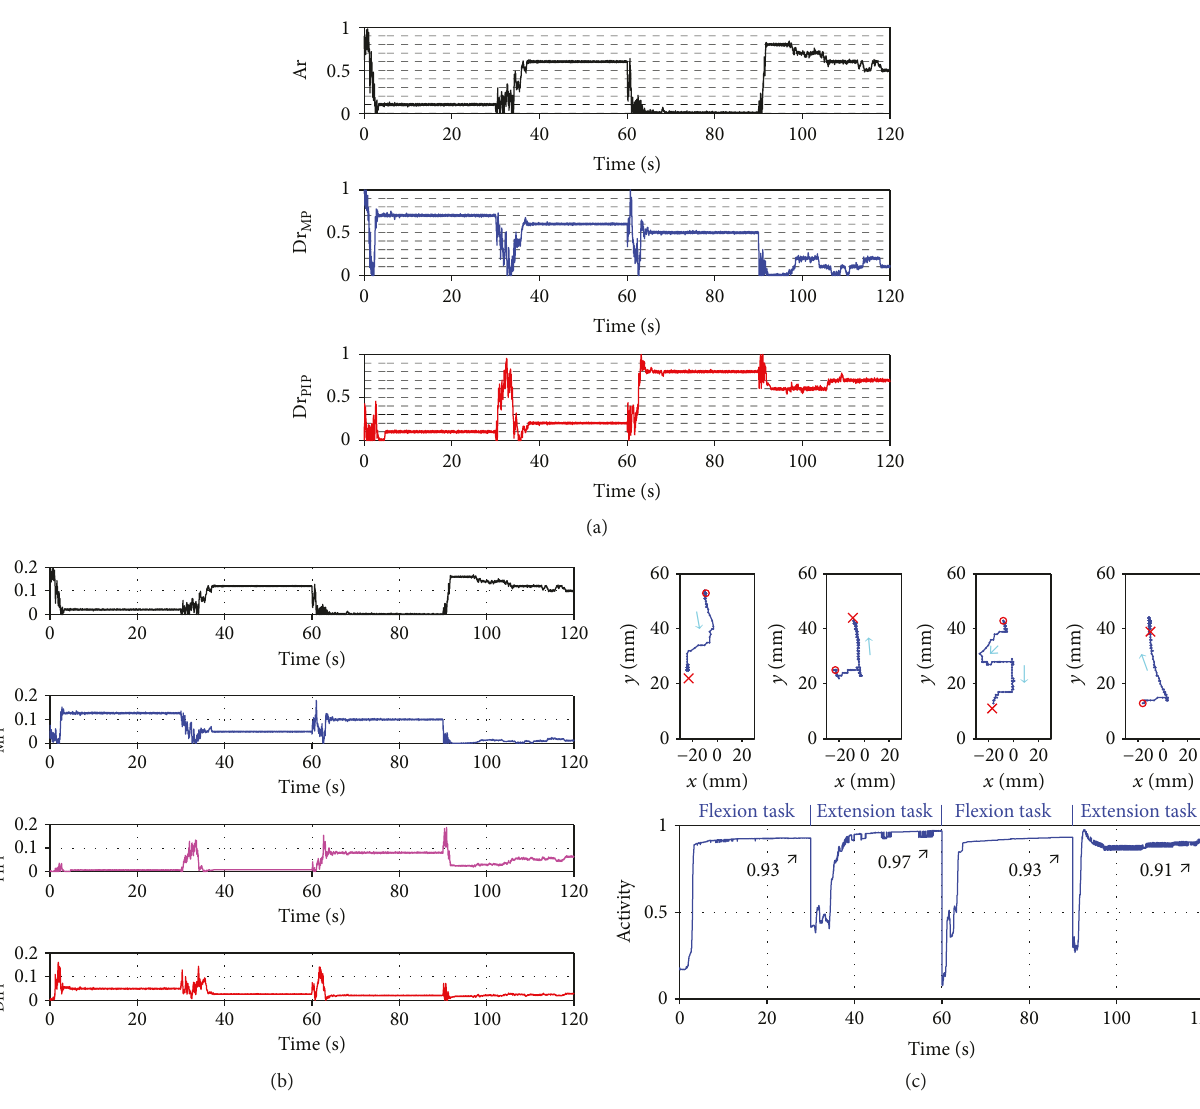
Figure 7: Results using the Ar and Dr search-type controller at four desired positions. (a) Plots of the transition of the search variable ( Ar , Dr MPf , and Dr PIPf ). (b) Plots of the transition of the input pressures ( P e , P MPf , P PIPf , and P DIPf ). In (c), the top images plot the trajectory of the tip of the robot: the fi rst fl exion task, the fi rst extension task, the second fl exion task, and the second extension task from the left image, whereas the bottom image plots the transition of the Activity . Cyan arrows and black arrows show the direction of the movement and the value of Activity ,